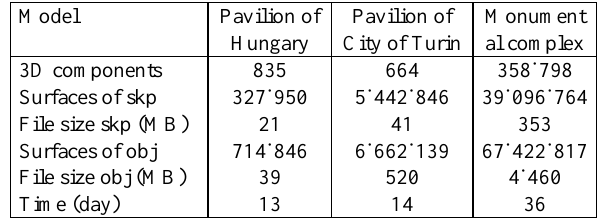
Table 1. Characteristics of each model